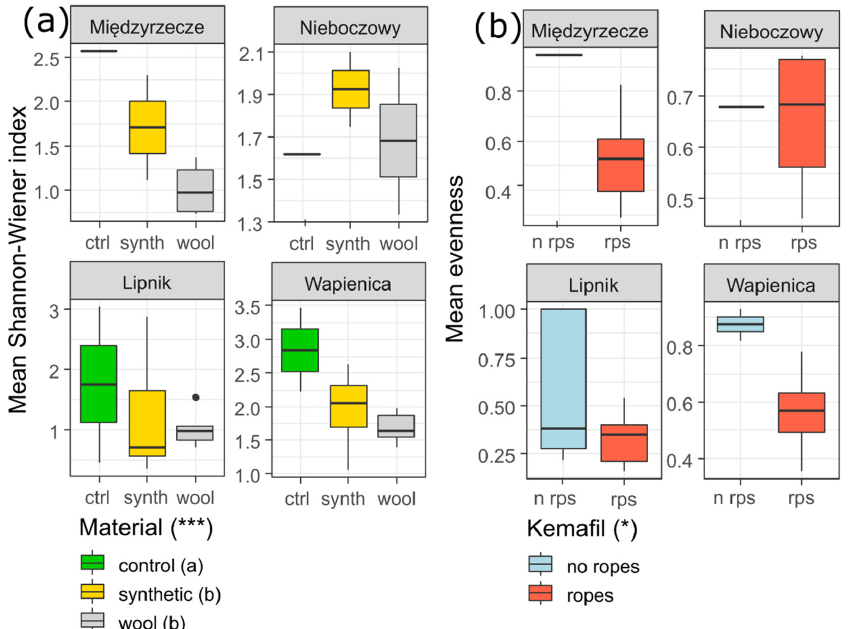
Figure 5. Comparison of the mean value of Shannon–Wiener index of the study plots within and among the sites and among the types of material ( a ) and Kemafil ( b ). Explanation: the ANOVA results refer to the comparison among the material types and between Kemafil types *** p < 0.001, * * p < 0.05. The types of material (indicated by different letters) showed significant differences among the groups of plots according to the post hoc test LSD Fisher test at p < 0.05.